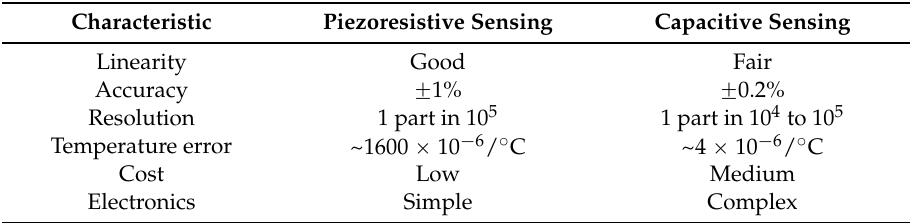
Table 1. Comparison between piezoresistive and capacitive sensing mechanisms. Characteristic